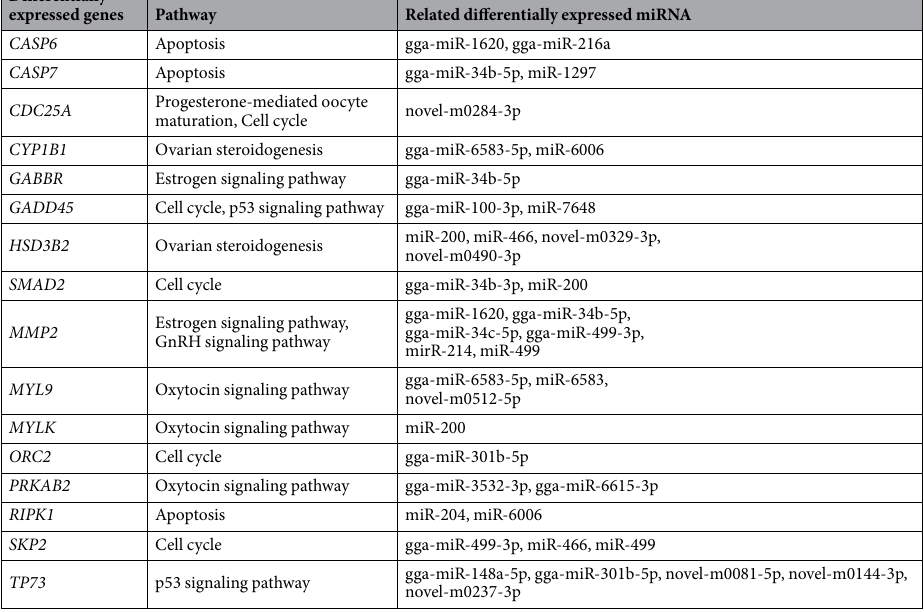
Table 1. Sixteen intersection genes and their corresponding pathways and differentially expressed miRNAs * . * Relative abundance of the gene or miRNA when comparing the performance between the broody ovary library and the egg-laying ovary library sequenced by deep sequencing.